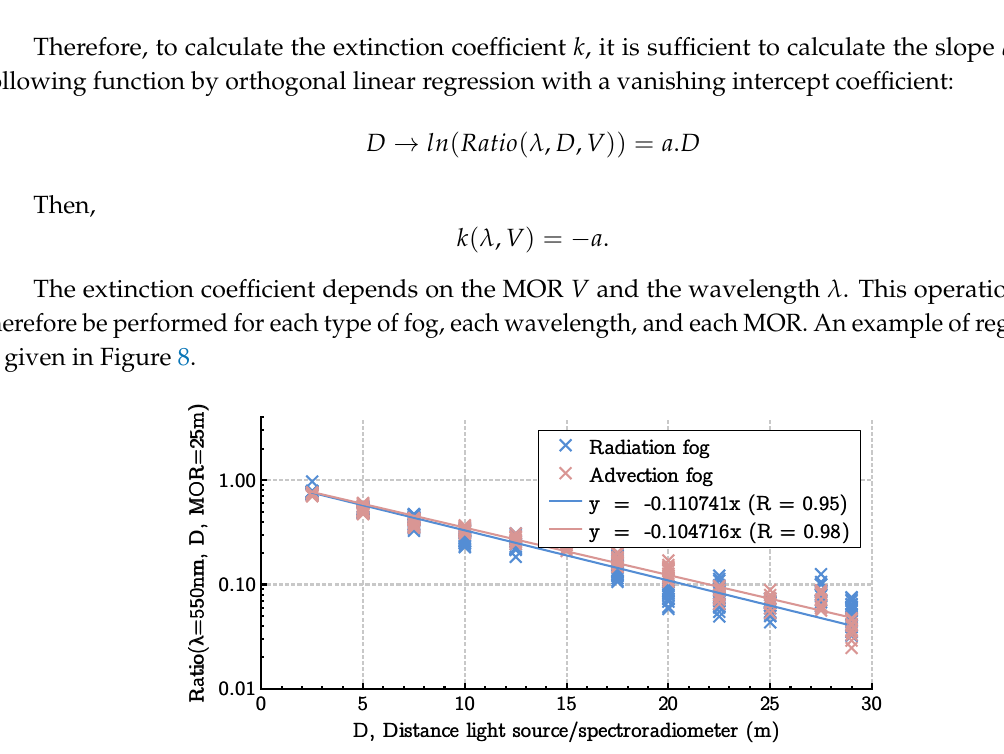
Figure 8. Ratio ( λ , D , V ) as a function of D for λ = 550 nm and V = 25 m for the two types of fog generated in the PAVIN BP